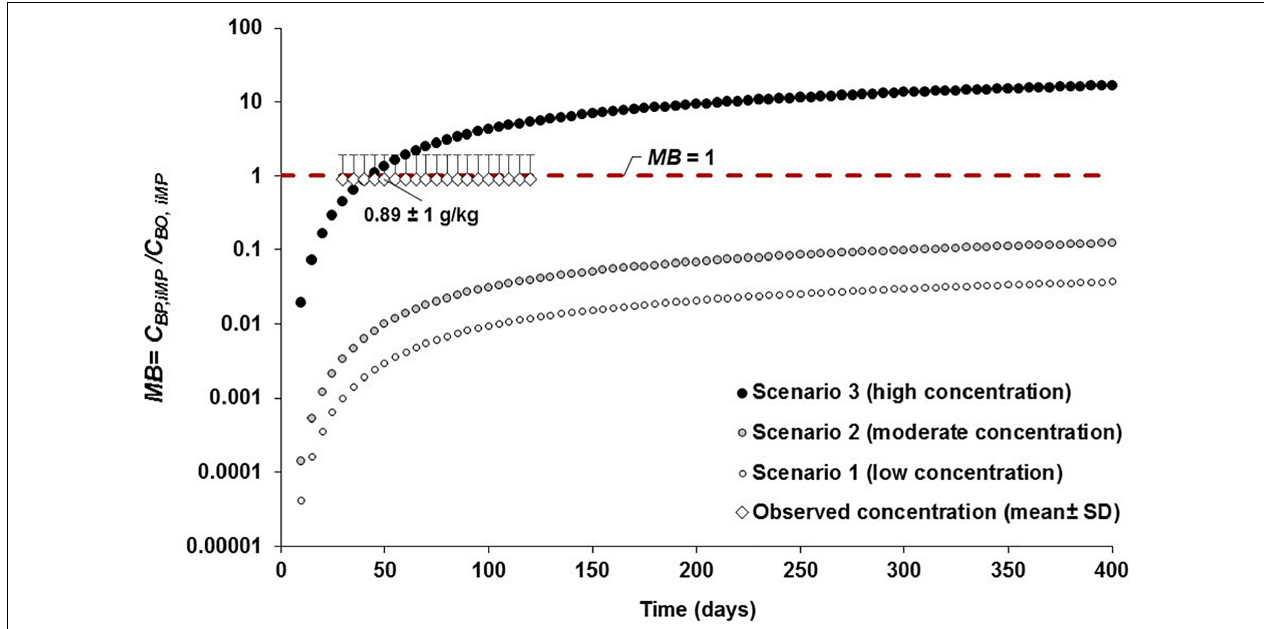
FIGURE 8 | Assessment of the model bias ( MB = C BP , iMP /C BO , iMP ; where C BP , i MP and C BO , i MP are the model predicted and observed MP concentrations in Chinook salmon, respectively) and performance of the model by comparing the simulations of MP concentrations projected in Chinook salmon from 0 to > 365 days under three abiotic concentrations scenarios (i.e., scenario 1: low concentration; scenario 2: moderate concentration; and, scenario 3: high concentration; see Supplementary Table S1 ) to the empirical field data (mean ± SD = 1.2 ± 1.4 particles/individual or 0.89 ± 1.0 g/kg) of MP concentration observed in wild juvenile Chinook salmon (Collicutt et al., 2019). The red dashed line represents equal concentration of MPs ( MB = 1) between predicted and observed concentration